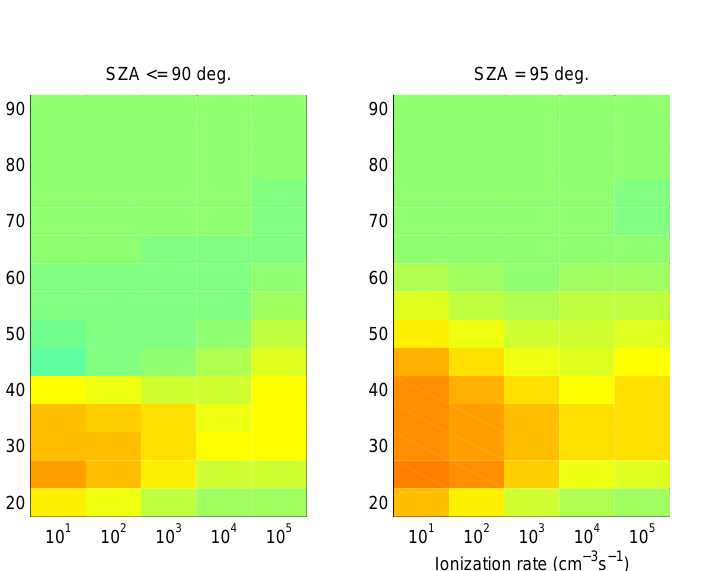
/Q for October 3